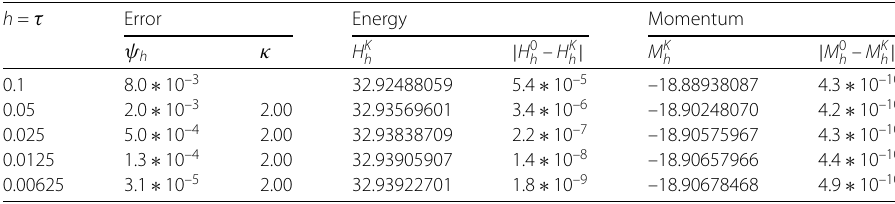
Table 2 Error, energy and momentum for Problem 1 using